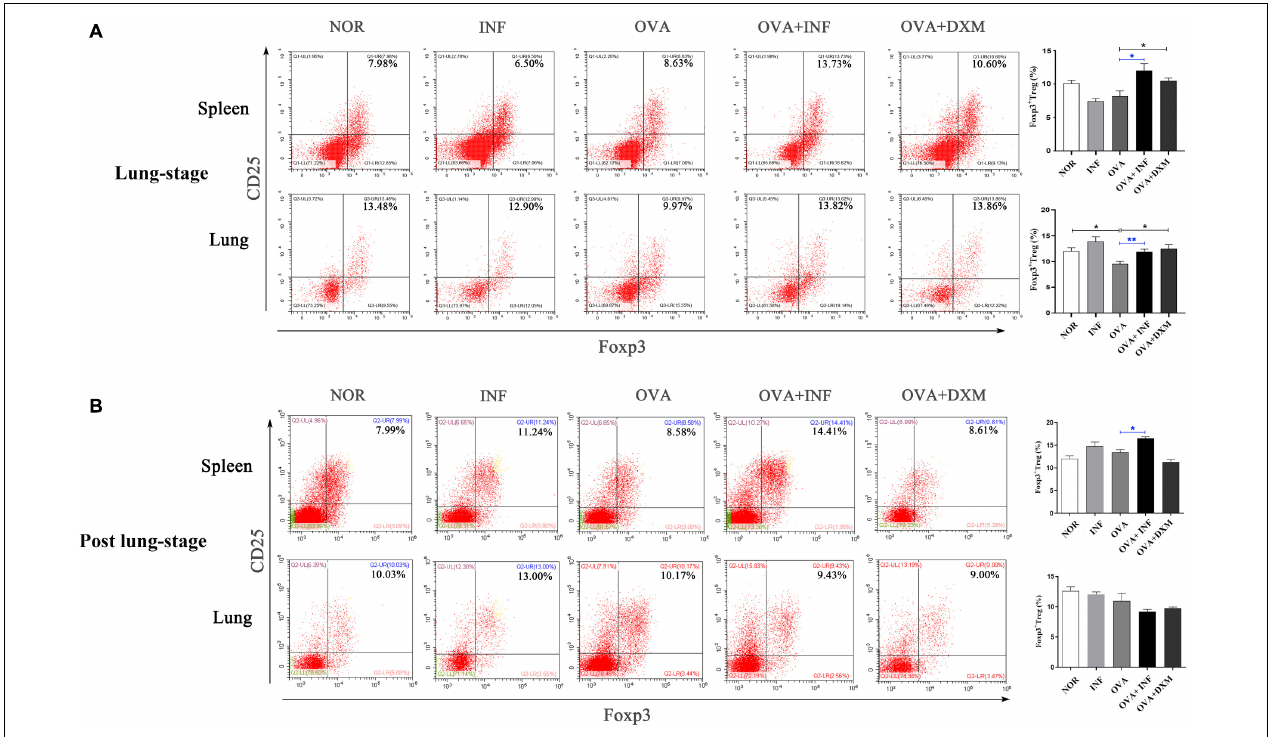
FIGURE 4 | Lung-stage S. japonicum infection upregulated Treg cell frequency in lung and spleen after OVA challenge. (A,B) Comparisons of Treg cell populations (CD4 + CD25 + Foxp3 + Treg cell) in lungs and spleens among all groups. Representative data of flow cytometry analysis for each group are shown together with statistical comparisons. n = 5 or 6 mice per group, experiment performed twice. * P < 0.05, ** P < 0.01 by one-way analysis of variance (ANOVA) with Tukey